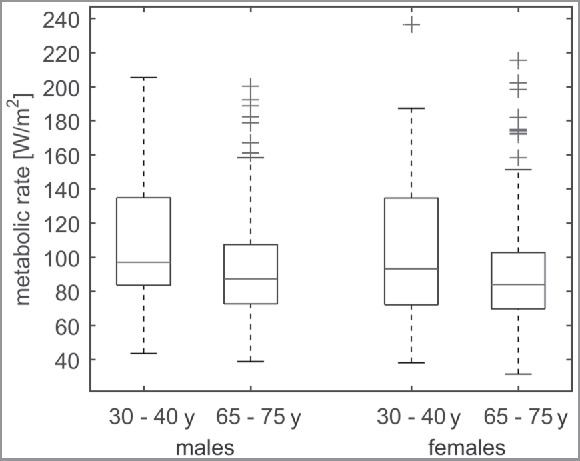
Calibrated metabolic rates of males and females for different age categories. The age groups 30–40 y and 65–75 y were chosen because information on these groups was available from the database of the Dutch central bureau for statistics (CBS) shown in Table 3.